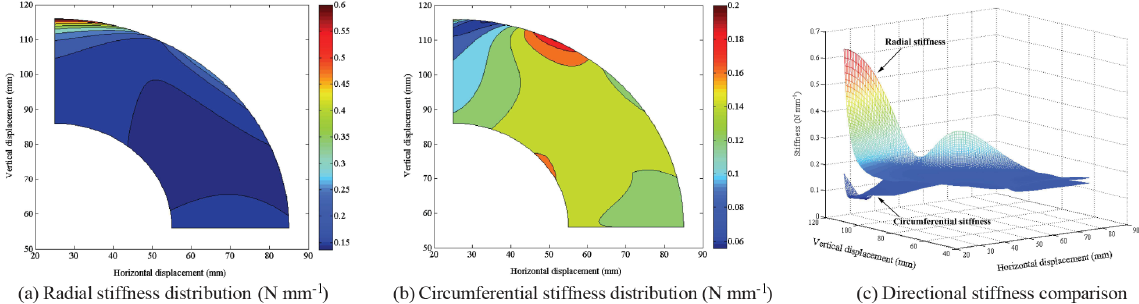
Figure 9. Stiffness distribution in radial and circumferential directions. The workspace is assumed to be an annular sector with radii 30 < r < 60(mm) and angle 90 ◦ (measured in radian), basing to the sample data.